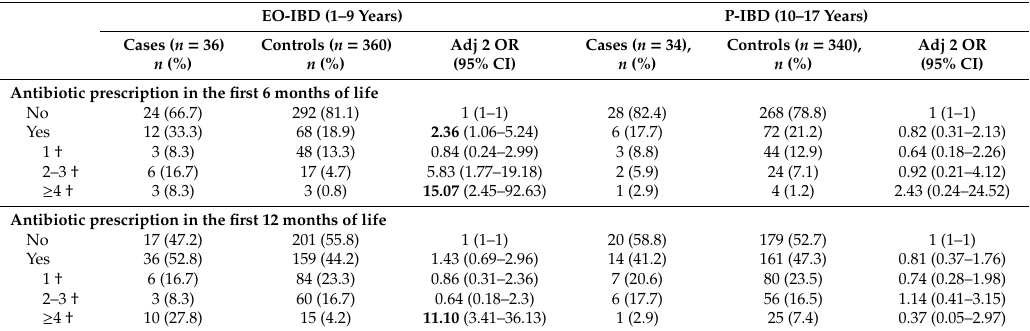
Table 4. Risks of antibiotic exposure in the first 6 and 12 months of life, on the development of childhood onset IBD, stratified by EO-IBD and P-IBD.